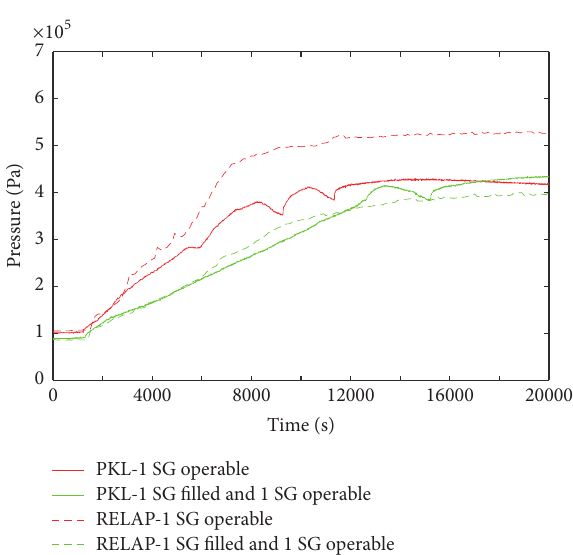
Figure 12: Primary pressure. PKL versus RELAP5. Steam generators influence. Phase I.